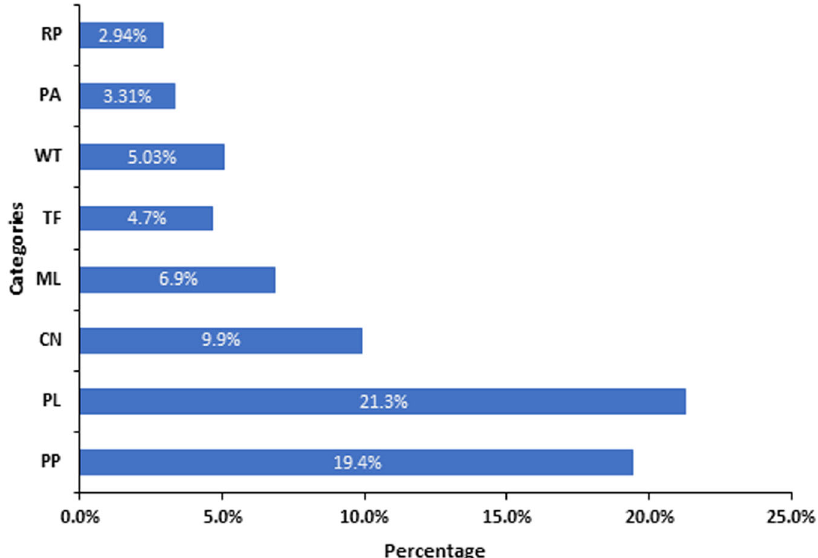
Fig. 4 Semantic categories. Top 8 semantic categories of N-collocates of Musharraf*